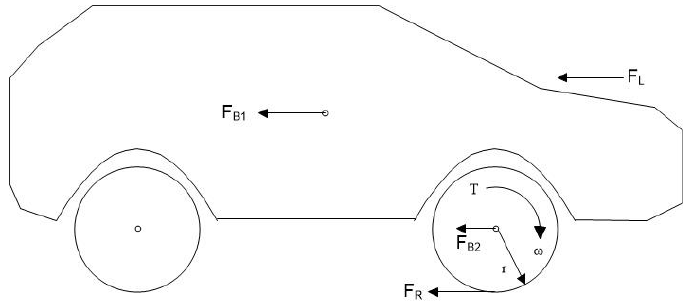
Figure 4. Vehicle forces and wheel